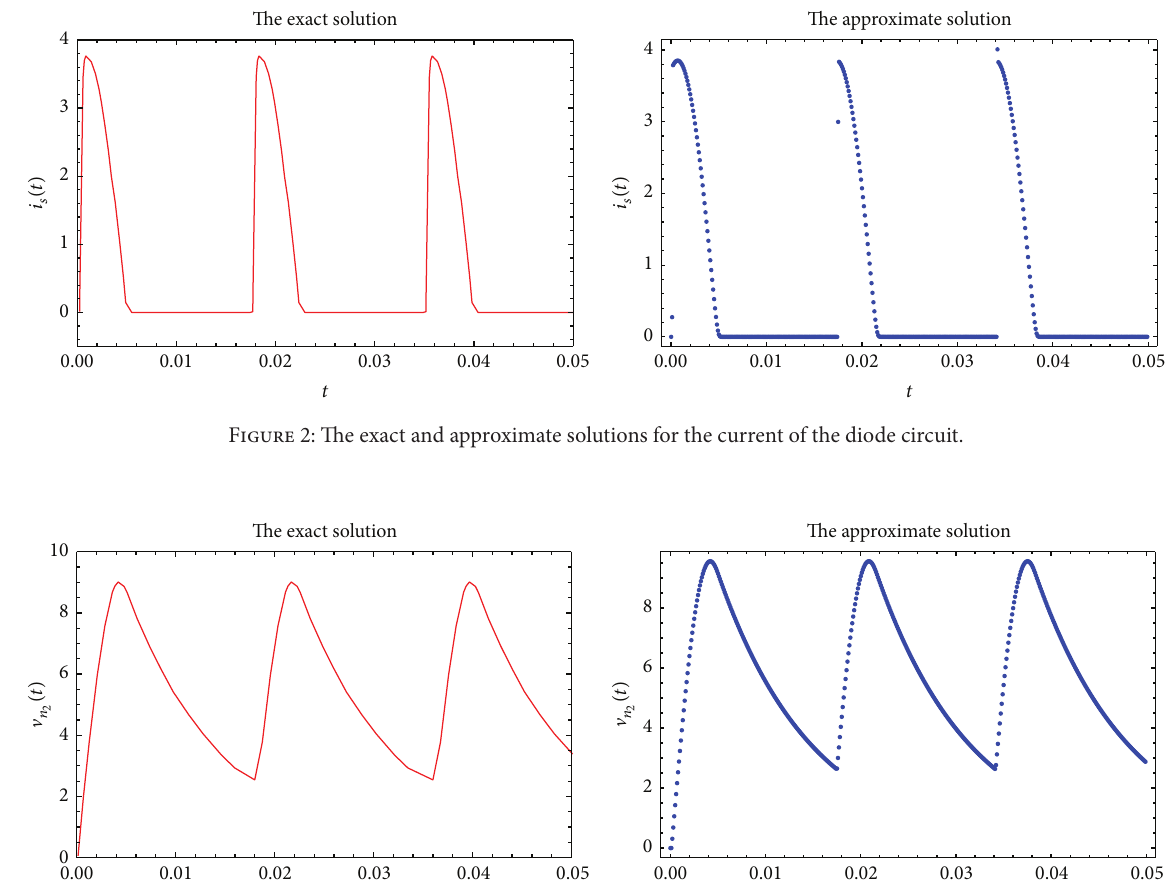
Figure 3: The exact and numerical solutions for the voltage ( V 𝑛